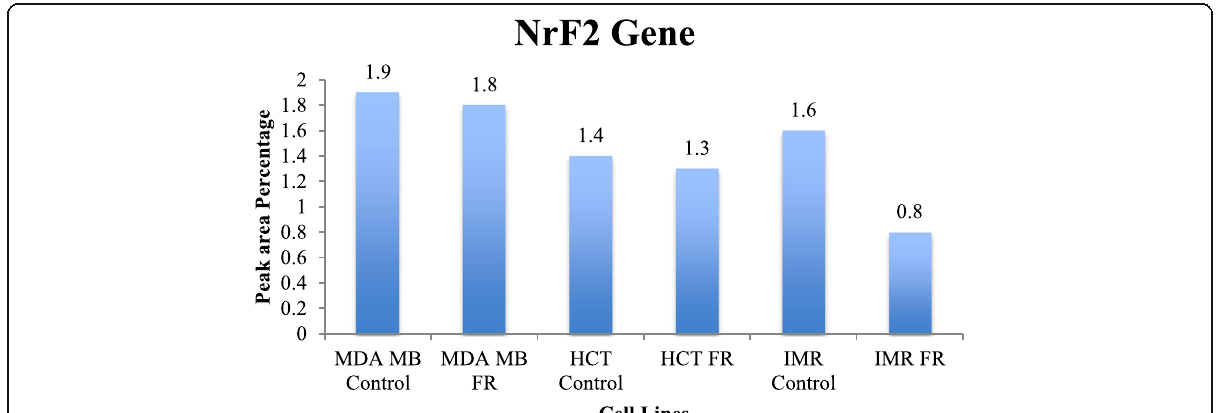
Fig. 14 The relative gene expression of Nrf-2 gene in all the cell lines. FR — Ficus